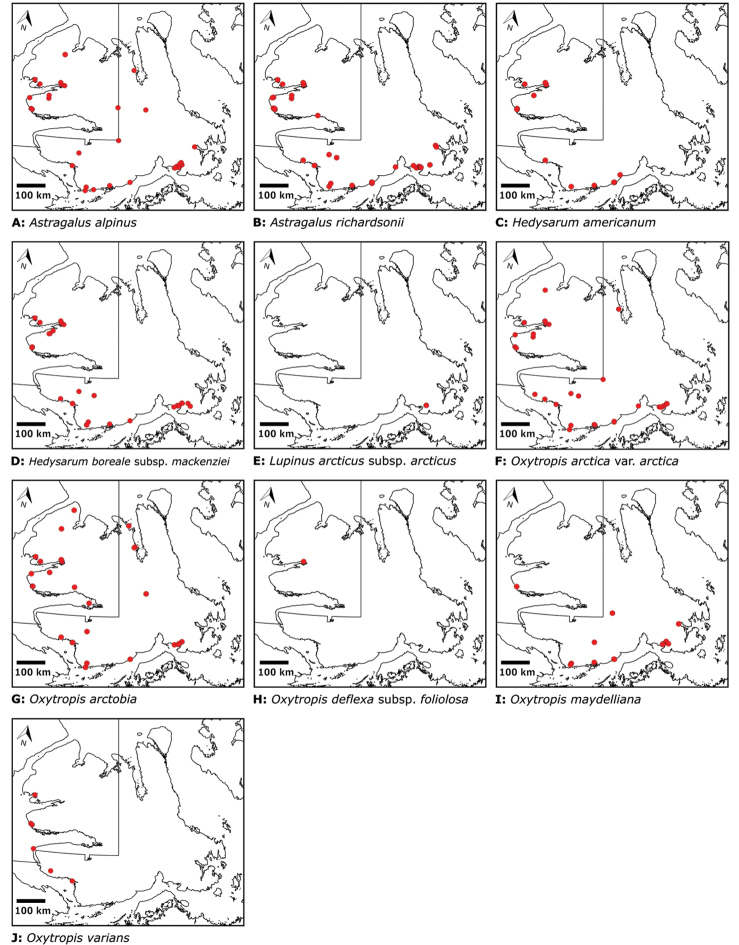
Species distribution maps. Fabaceae: AAstragalus
alpinusBAstragalus
richardsoniiCHedysarum
americanumDHedysarum
boreale
subsp.
mackenzieiELupinus
arcticus
subsp.
arcticusFOxytropis
arctica
var.
arcticaGOxytropis
arctobiaHOxytropis
deflexa
var.
foliolosaIOxytropis
maydellianaJOxytropis
varians.